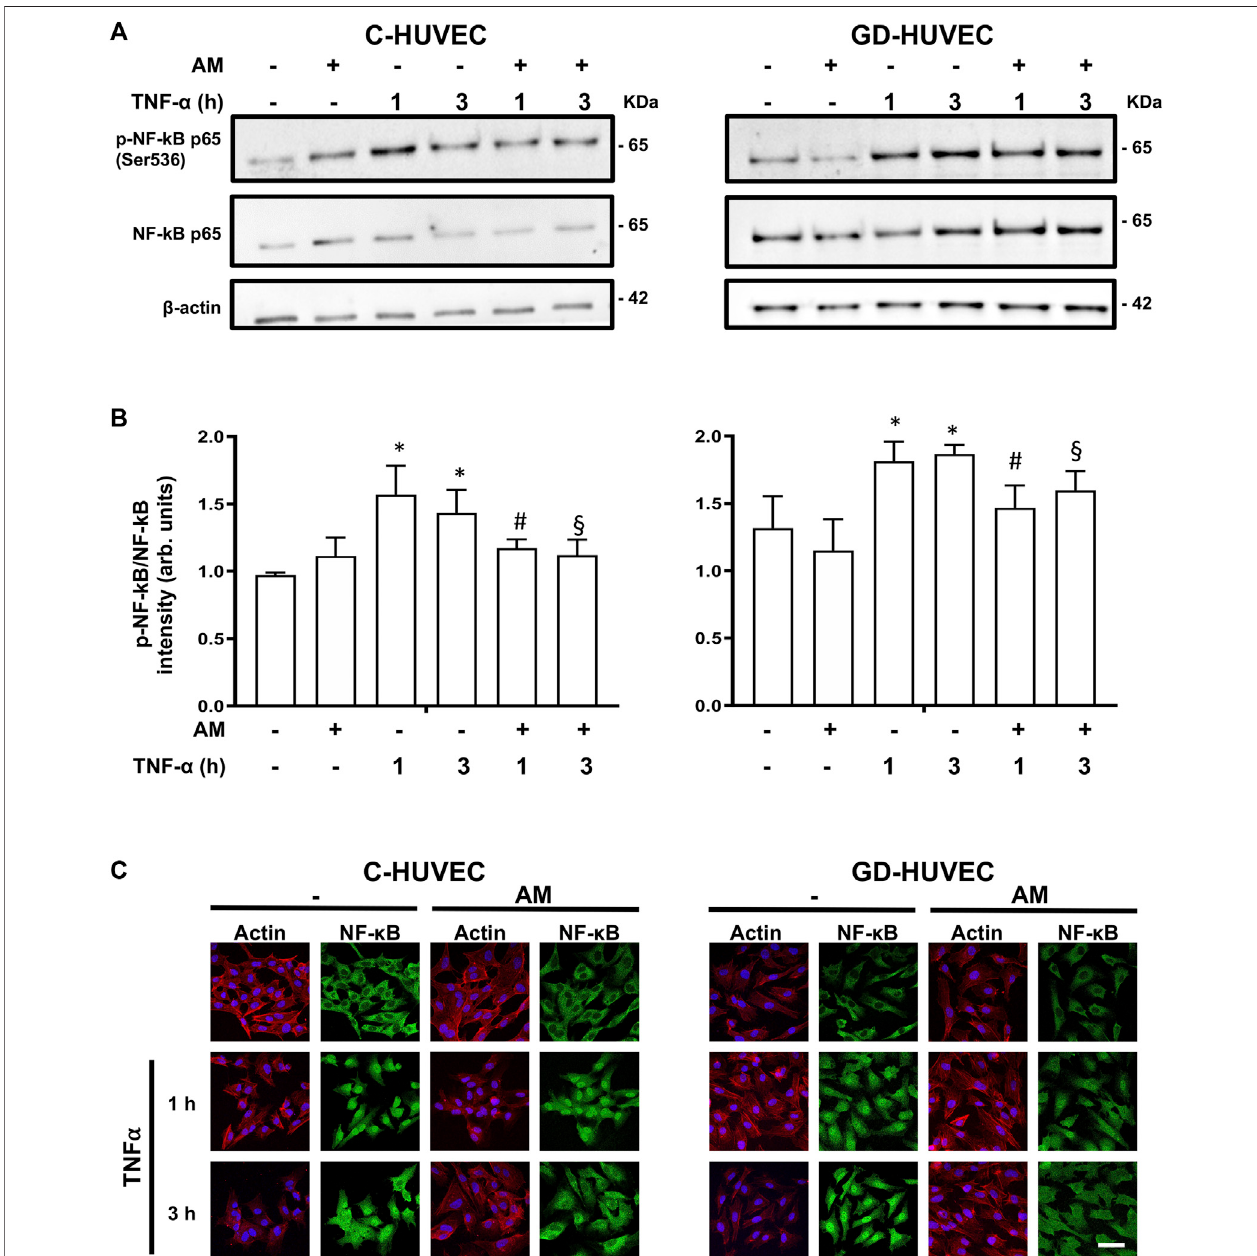
FIGURE 3 | Amniotic membrane attenuates TNF- ⍺ -induced NF- κ B phosphorylation and nuclear translocation. Sub-con fl uent C-HUVECs and GD-HUVECs were serum-starved,treatedwithAMfor24h,thenTNF- α wasaddedat1and3 h. (A) ProteinextractwasanalyzedforWBforthementionedantibodies. (B) Histogramsshow Western blot quanti fi cation of NF- κ B phosphorylation experiments ( n = 3); * p < 0.05 vs basal; # p < 0.05 vs TNF- α 1 h; § p < 0.05 vs TNF- α 3 h. (C) Samples were immunostained with a speci fi cantibody against NF- κ B and co-staining with Hoechst-33258 and phalloidin toreveal nuclei and he actin cytoskeleton, respectively. This experiment was repeated at least three times. Representative images are